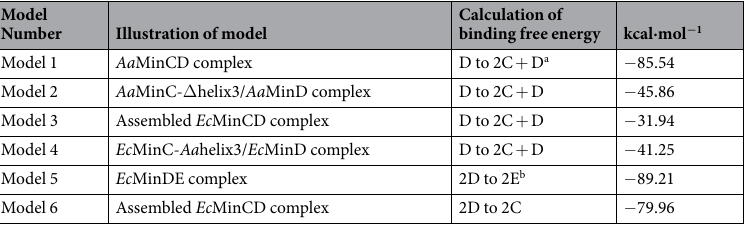
Table 1. Binding free energy calculation of protein complex. D to 2C + D a refers that in the model the binding free energy of one chain of MinD with the other three chains was calculated. 2D to 2E b refers that in the model the binding free energy of two MinD chains with the other two MinE chains was calculated.